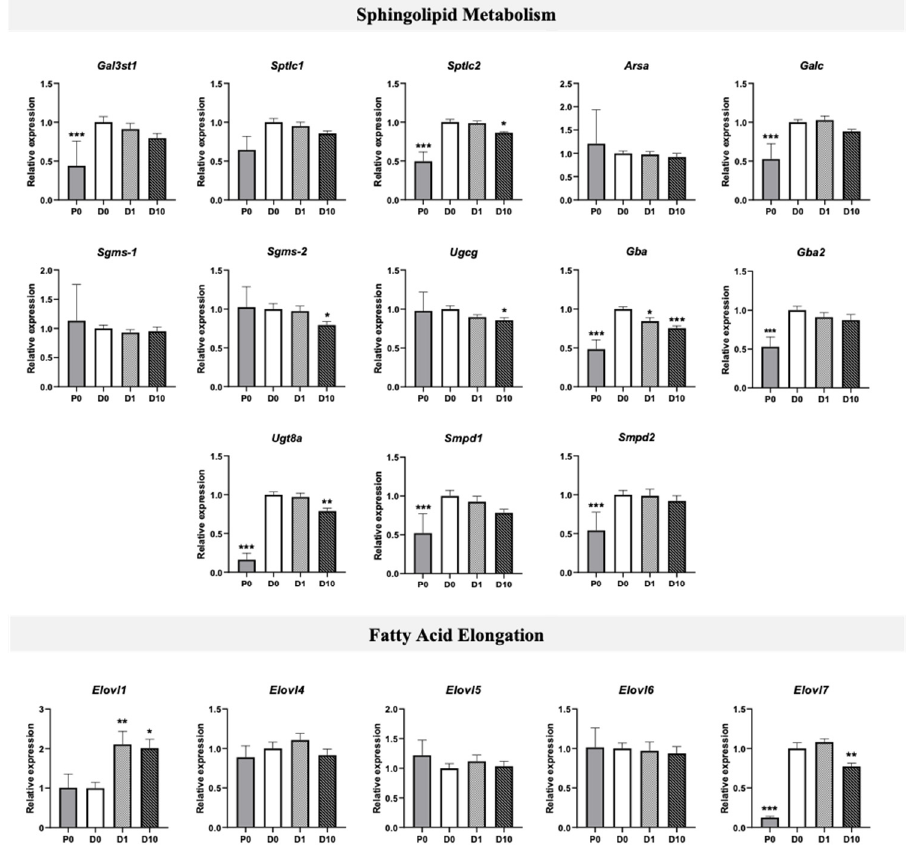
Figure 4. Gene expression of enzymes of lipid metabolism in Oli-neu cells: Gene expression analysis of sphingolipid metabolism (upper panel) and fatty acid elongation (lower panel): cerebroside sulfo- transferase enzyme ( Gal3st1 ), serine palmitoyltransferase long chain base subunit 1 ( Sptlc1 ), serine palmitoyltransferase long chain base subunit 2 ( Sptlc2 ), arylsulfatase A ( Arsa ), galactosylceramidase ( Galc ), sphingomyelin synthase 1 ( Sgms1 ), sphingomyelin synthase 2 ( Sgms2 ), UDP-glucose ceramide glucosyltransferase ( Ugcg ), glucosylceramidase beta ( Gba ), glucosylceramidase beta 2 ( Gba2 ), UDP-galactosyltransferase ( Ugt8a ), sphingomyelin phosphodiesterase 1 ( Smpd1 ), sphingo- myelin phosphodiesterase 2 ( Smpd2 ), elongases 1 to 7 ( Elovl1 to 7 ). P0—proliferating cells, D0—dif- ferentiated control cells, D1—differentiated cells exposed to BPA 1 µM, D10—differentiated cells exposed to BPA 10 µM. N = 6–9, relative expression was normalized to reference gene Rpl13a , all groups were compared to D0 control group, (one-way ANOVA and Dunnett multiple comparison post-test, * p < 0.05, ** p < 0.01, and *** p < 0.001).